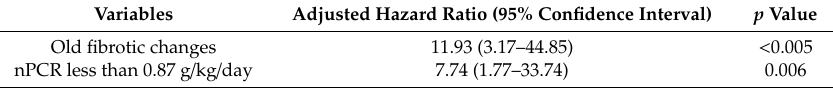
Figure 1. Box plot comparison of normalized protein catabolic rate ( A ) and Kt / V ( B ) between the two groups. Table 2. Variables associated with latent tuberculosis infection.